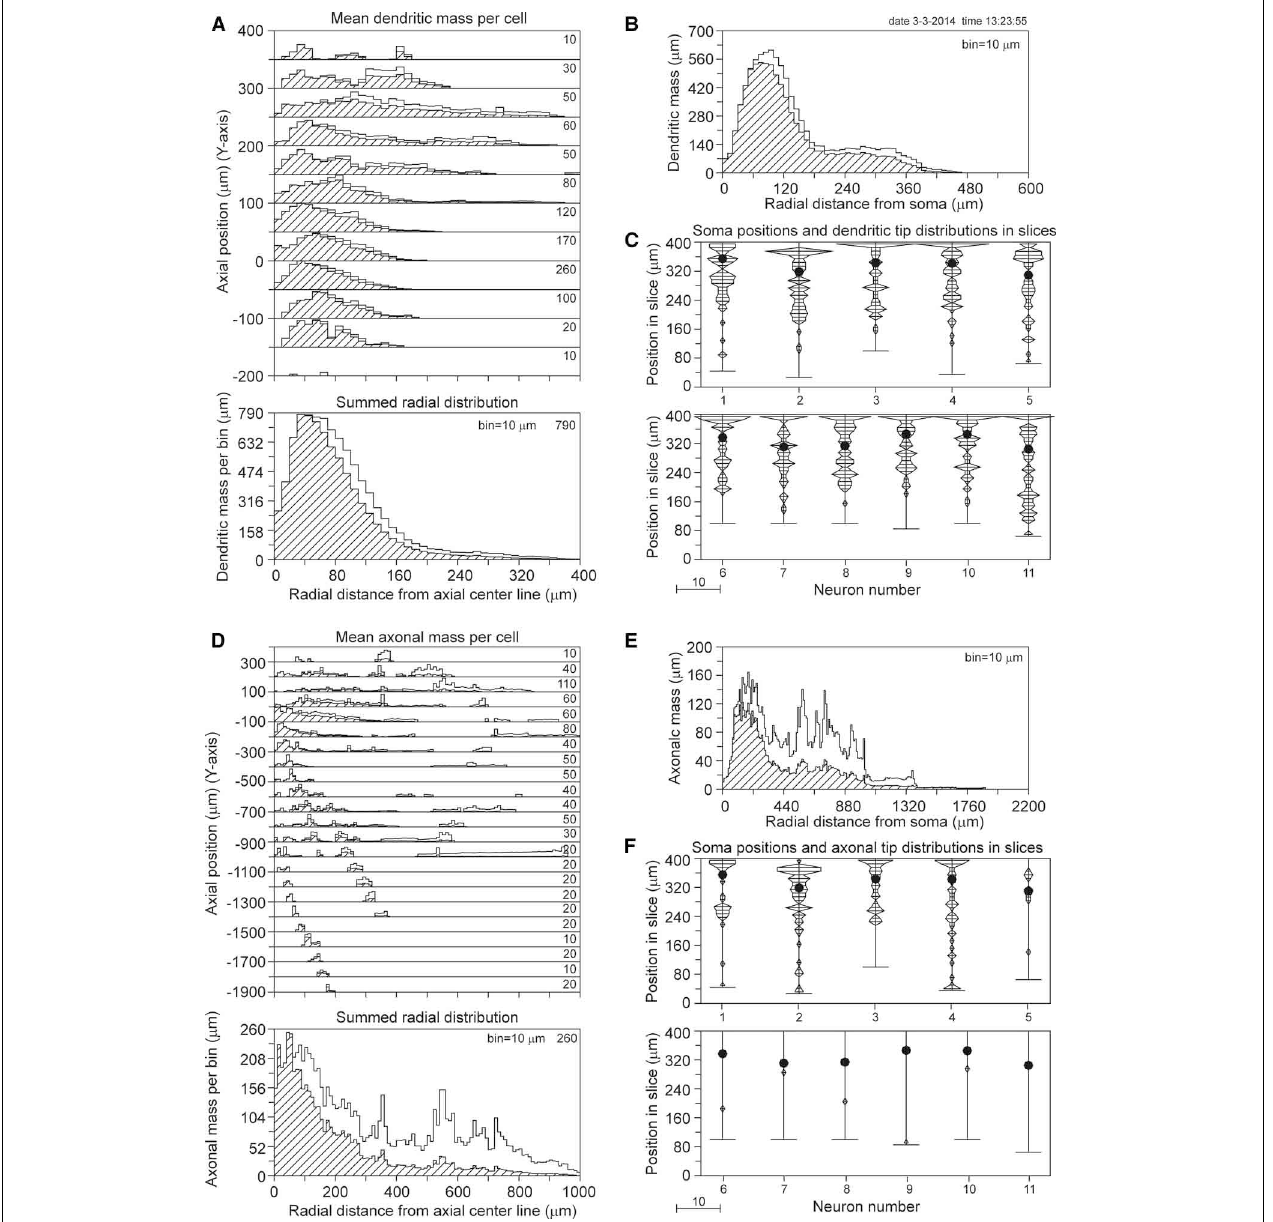
FIGURE 7 | Mass completion of rat cortical L2/3 pyramidal neurons reconstructed from 300 µ m thick slices by Shepherd and Svoboda (2005), and obtained from the NeuroMorpho.org database. For the description of the different panels see the legend of Figure 4 . Lacking information on the soma positions in the slices, we aligned